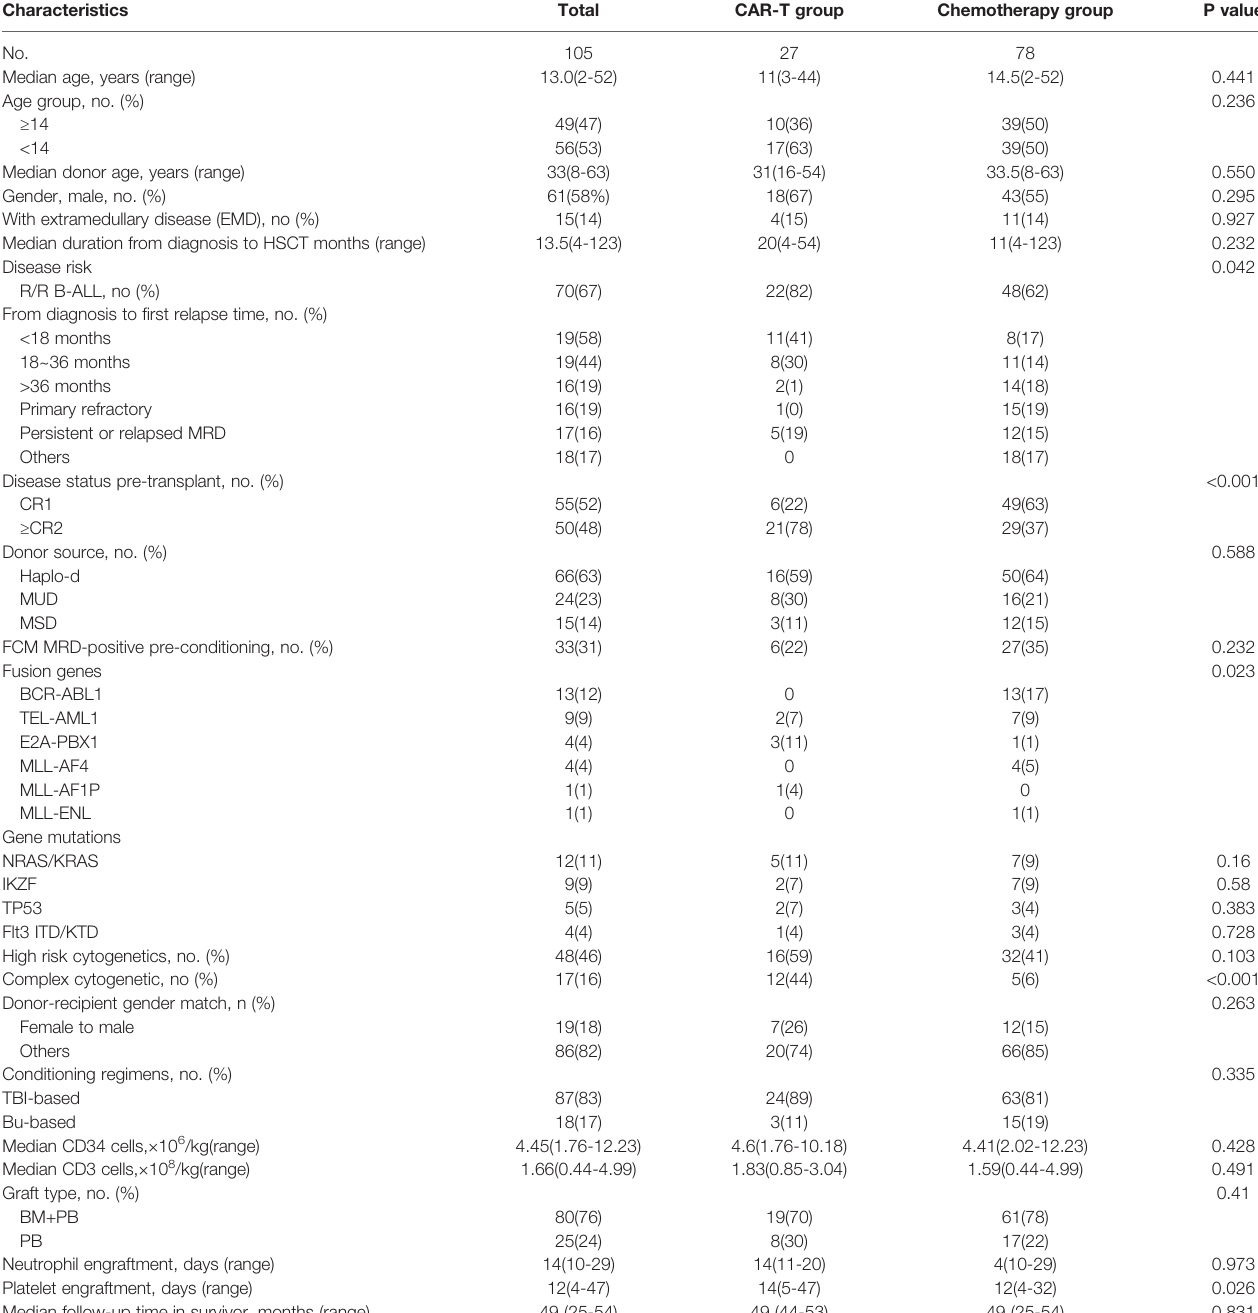
TABLE 1 | Patient